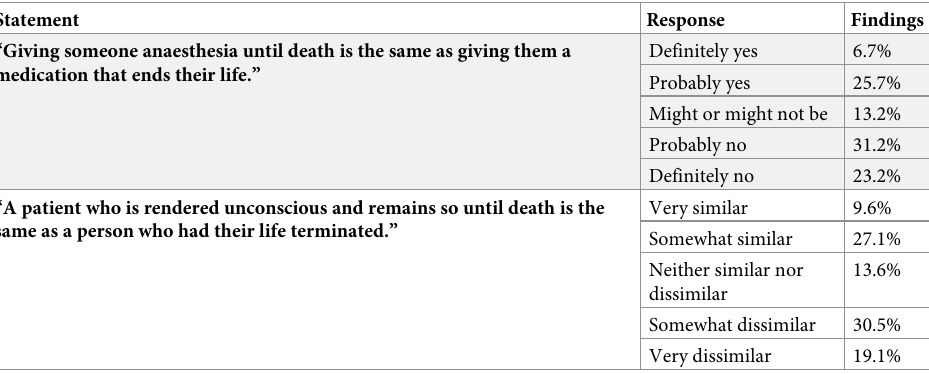
Table 3. Comparing terminal anaesthesia to euthanasia (n =